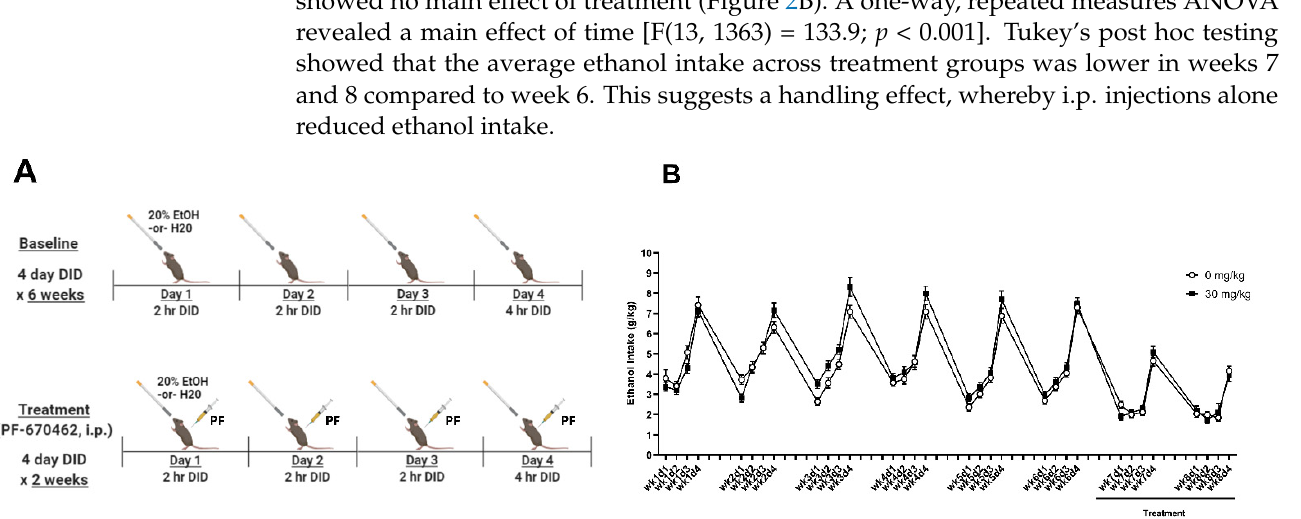
Figure 2. The CK1E/D inhibitor, PF-670462, did not reduce chronic binge-like ethanol intake in female HDID-1 mice. ( A ) Experimental timeline for baseline binge-like drinking (weeks 1–6) and PF-670462 treatment relative to DID (weeks 7 & 8). ( B ) Ethanol intake (g/kg) for Days 1–4 across 6-weeks with PF-670462 treatment administered in weeks 7 and 8. Average 2-h ethanol intake during Days 1–3 for weeks 7 and 8 revealed no main effects of treatment [F(1, 24) = 0.001], day [F(1, 24) = 0.70], or treatment x day interactions [F(1, 24) = 3.11]. Average 4-h ethanol intake on Day 4 during weeks 7 and 8 revealed no main effect of treatment.